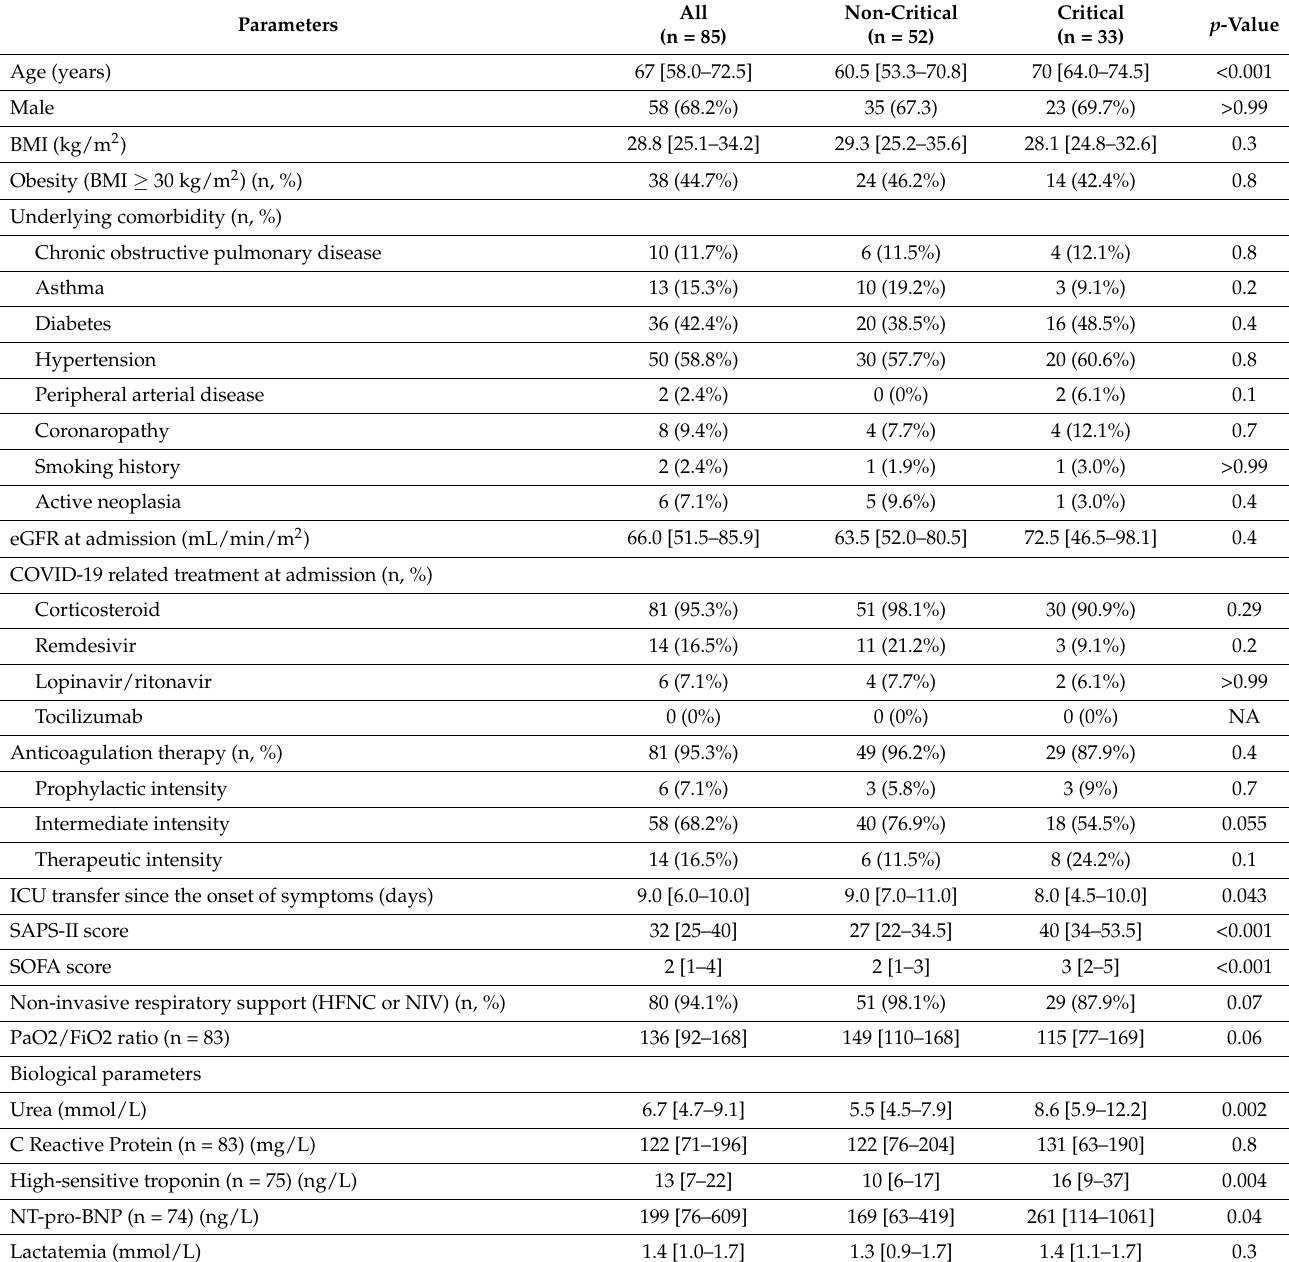
Table 1. Clinical and biological characteristics at admission in